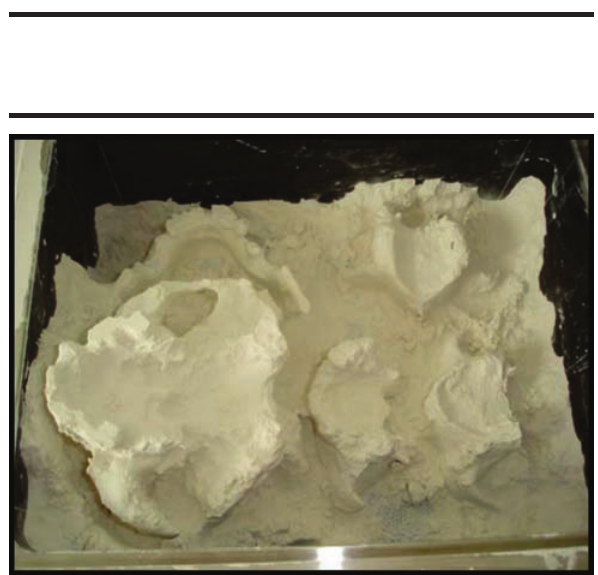
FIGURE 4 – Mandible three-dimensional reconstruction made in the Dental Slice software